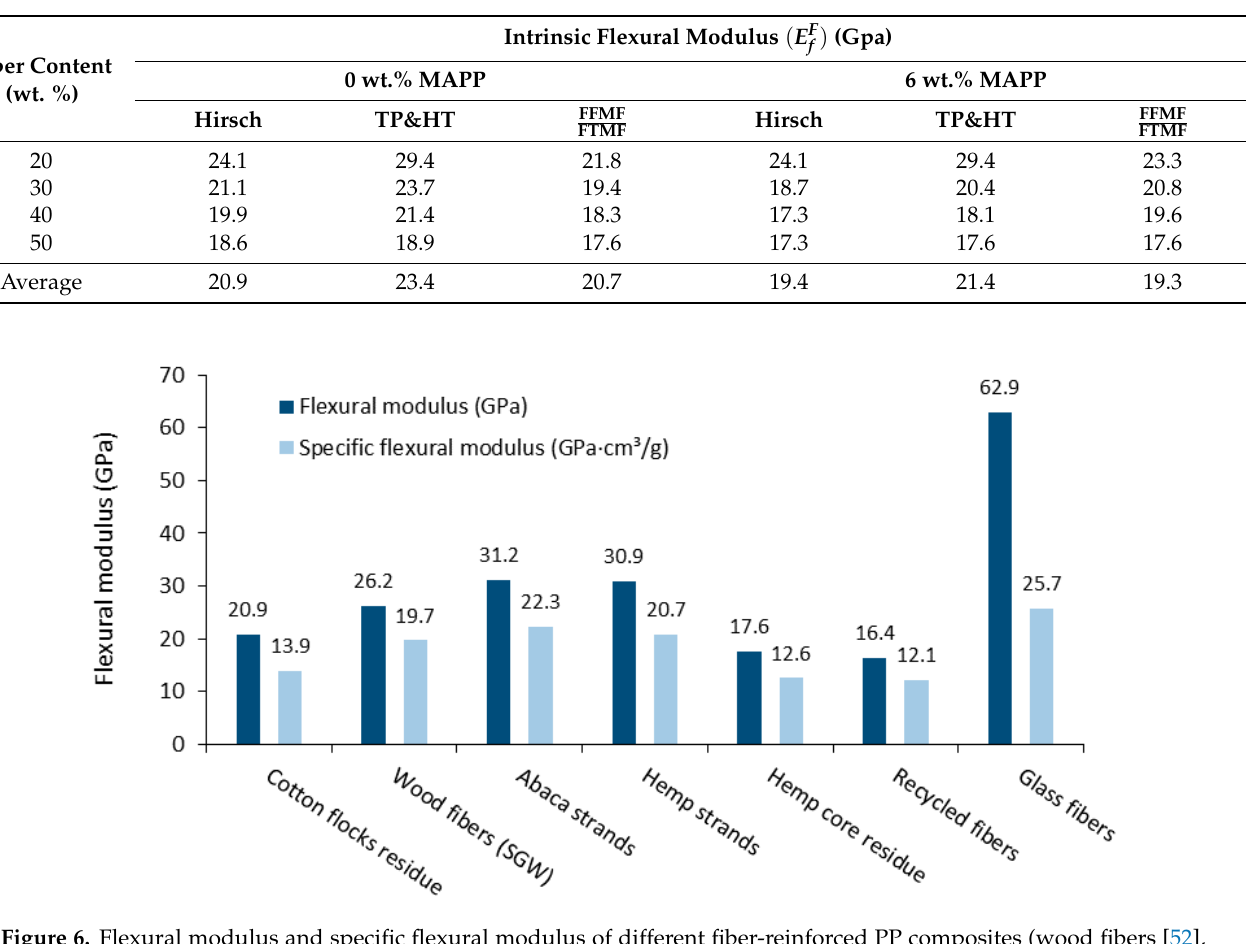
Table 5. Micromechanics of the flexural modulus. Intrinsic flexural strength ( 𝐸 (cid:3033)(cid:3007) ), modulus efficiency factor ( 𝜂 (cid:3032) ), length factor ( 𝜂 (cid:3039) ), orientation factor ( 𝜂 (cid:3042) ), limit angle ( 𝛼 (cid:3042) ), mean orientation angle ( 𝛼 ). Coupling Agent Content Factor 0 wt.% MAPP